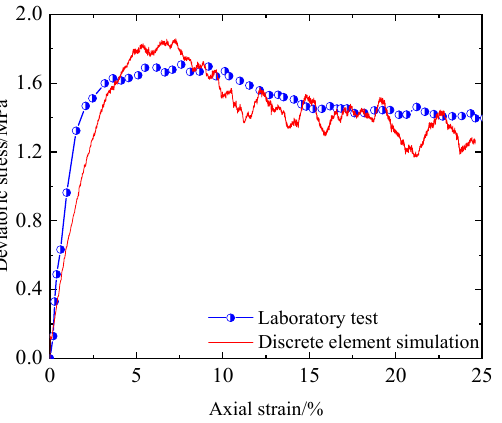
Figure 7. Biaxial discrete element numerical model and microstructure of gas hydrate deposits.